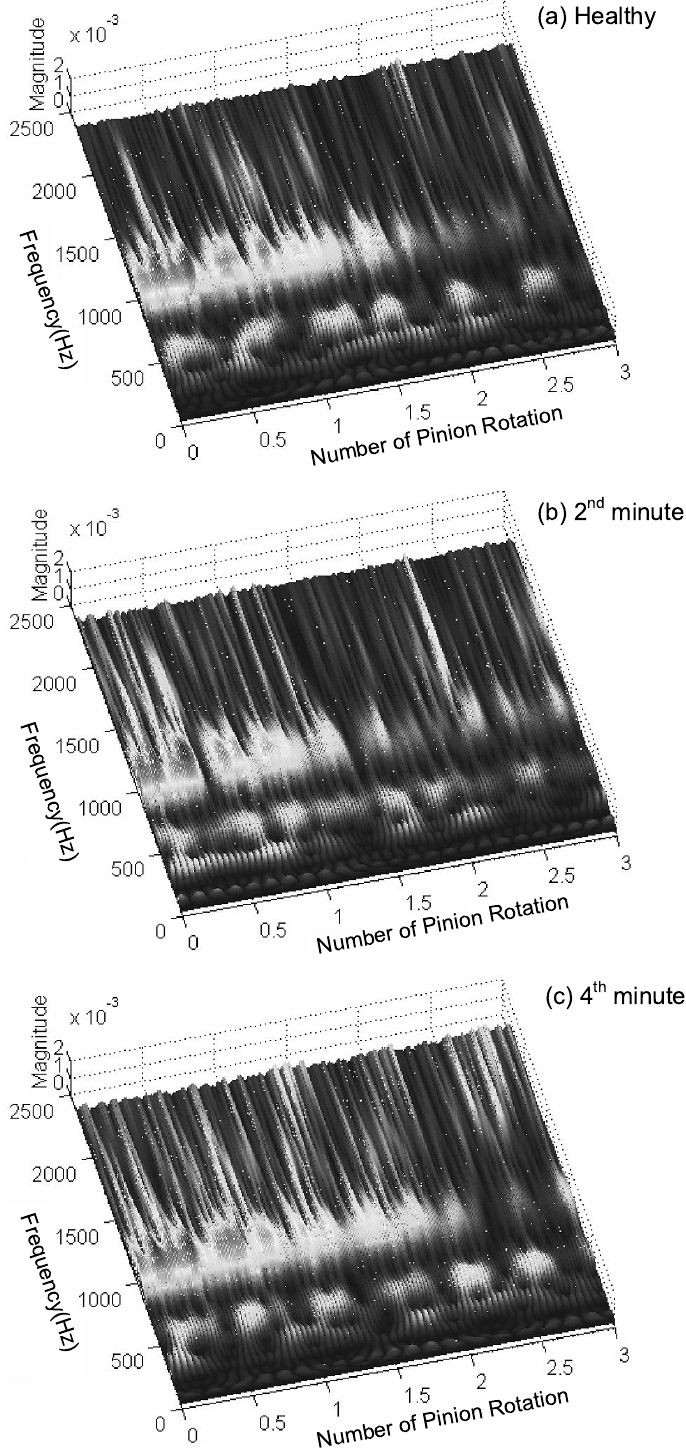
Fig. 12. Maps of wavelet transforms of the gear vibrations between 0–4